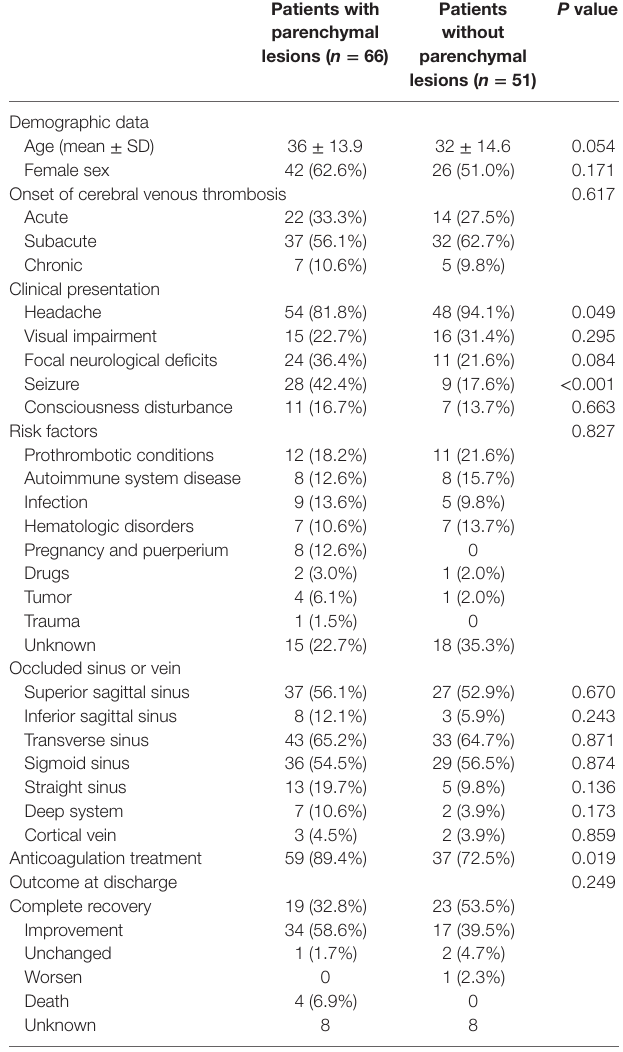
TaBle 1 | The comparison of baseline data, clinical presentation, risk factors and radiological findings of patients with and without parenchymal lesions. Patients with parenchymal